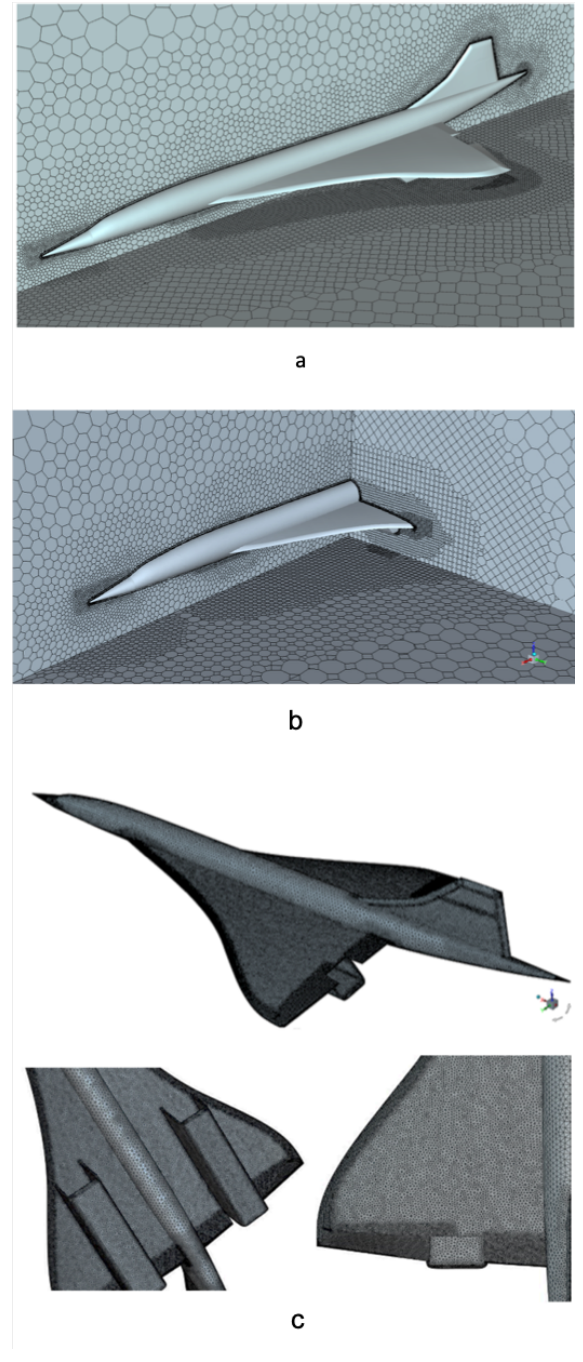
Figure 4. ( a ) Volume polyhedral mesh; ( b ) detail of mesh refinement; ( c ) surface